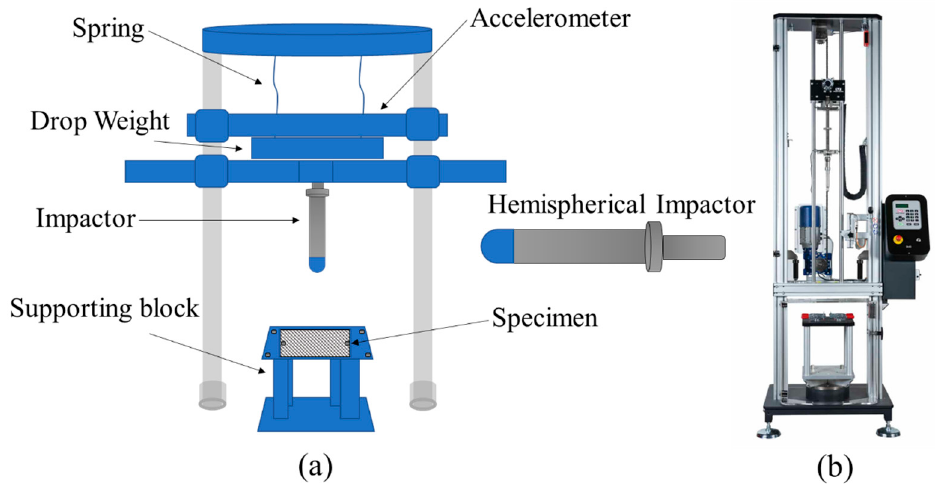
Figure 2. Impact setup on UACS laminate using the hemispherical impactor. ( a ) Schematic diagram. ( b ) Instron CEAST 9350 Drop Tower Impact System 3. Finite element modeling.